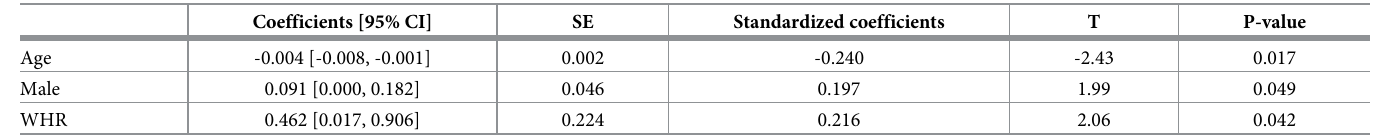
Table 5. Multiple regression analysis (60 min after the surgical incision).